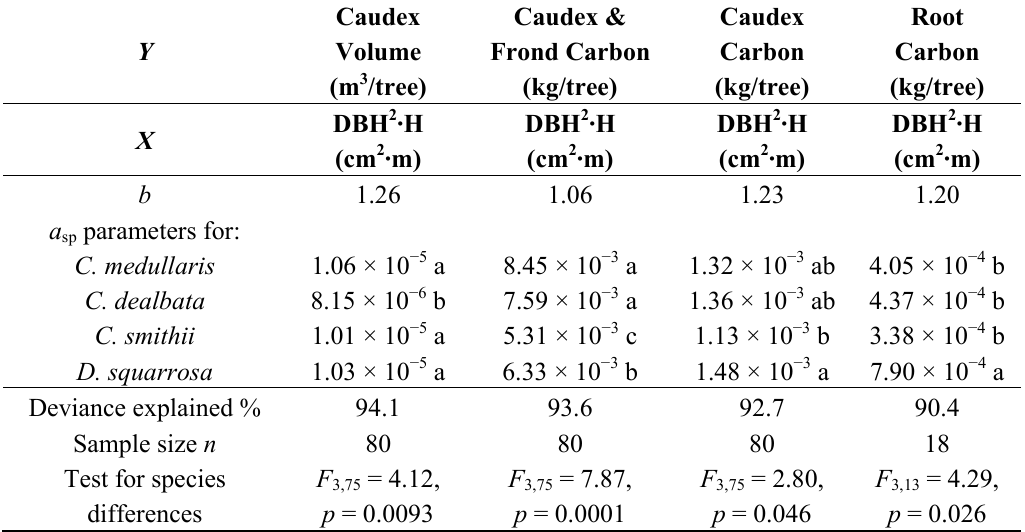
Table 6. Allometric equations for estimating caudex volume and component carbon for tree ferns with species specific parameters. Values in a column followed by the same letter do not differ significantly (least significant difference test with p =